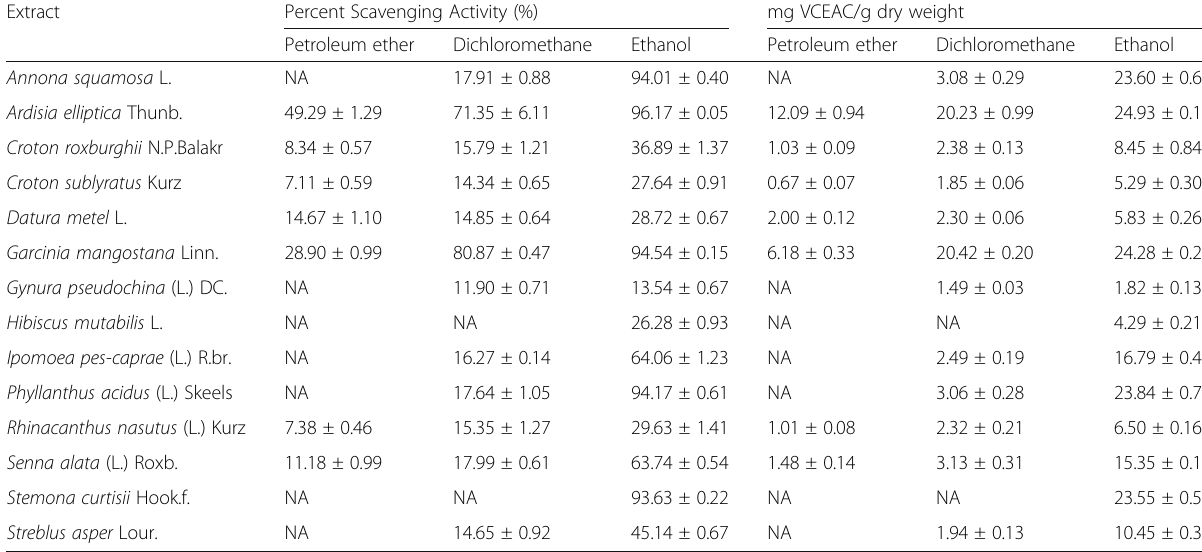
Table 3 Free Radical Scavenging activity by DPPH assay Extract Percent Scavenging Activity (%) mg VCEAC/g dry weight Petroleum ether Dichloromethane Ethanol Petroleum ether Dichloromethane Ethanol Annona squamosa